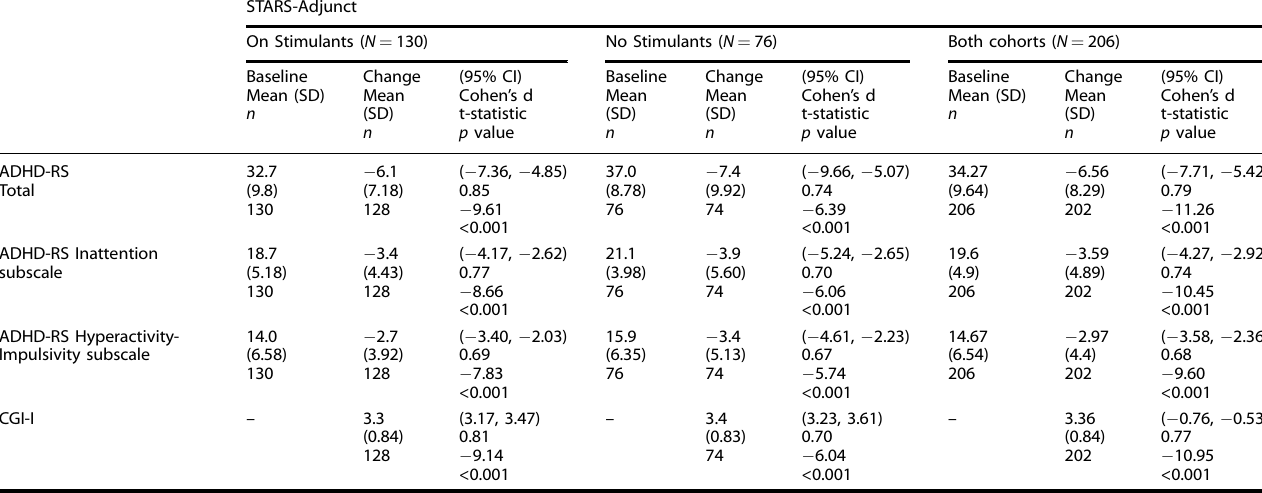
Table 2. STARS-Adjunct Secondary Endpoints (ITT), change from Baseline to Day 28.